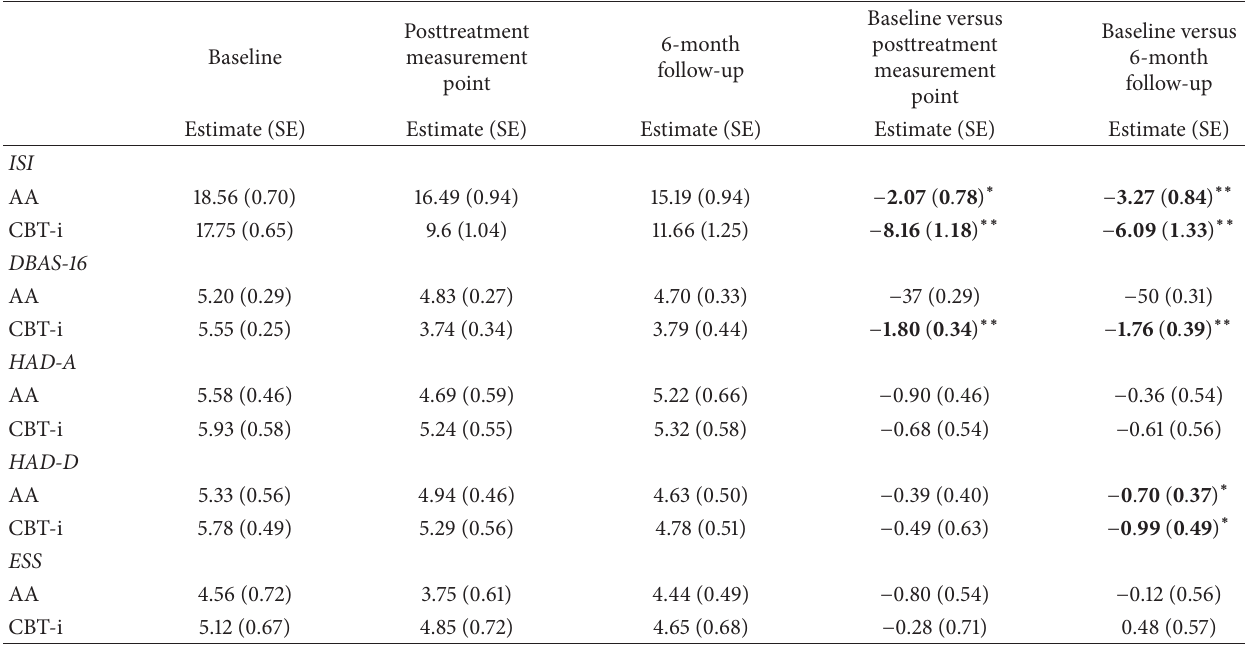
Table 1: Linear mixed models with within-group effects for AA and CBT-i. Outcome variables are Insomnia Severity Index (ISI), Dysfunctional Beliefs and Attitudes about Sleep scale (DBAS-16), Hospital Anxiety and Depression scale (HAD-A, HAD-D), and Epworth Sleepiness Scale (ESS).